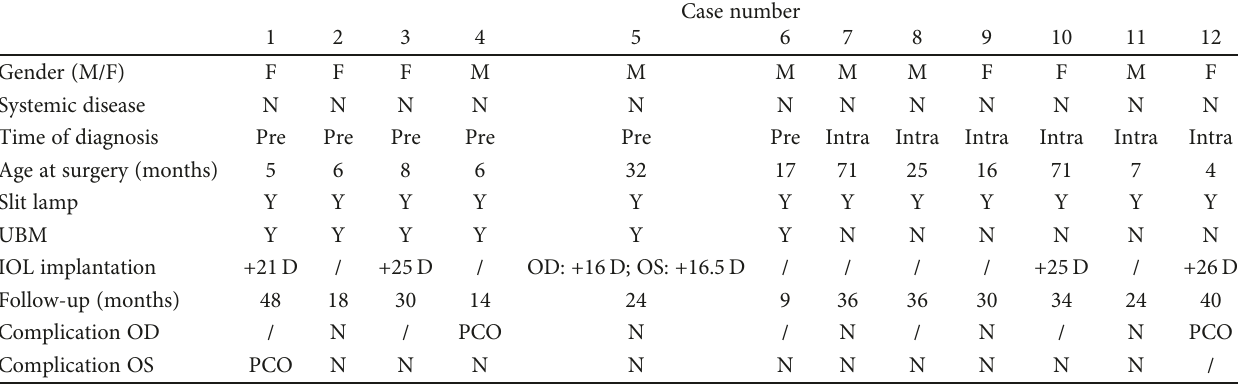
Table 2: Characteristics of patients surgically treated for congenital membrane cataract.